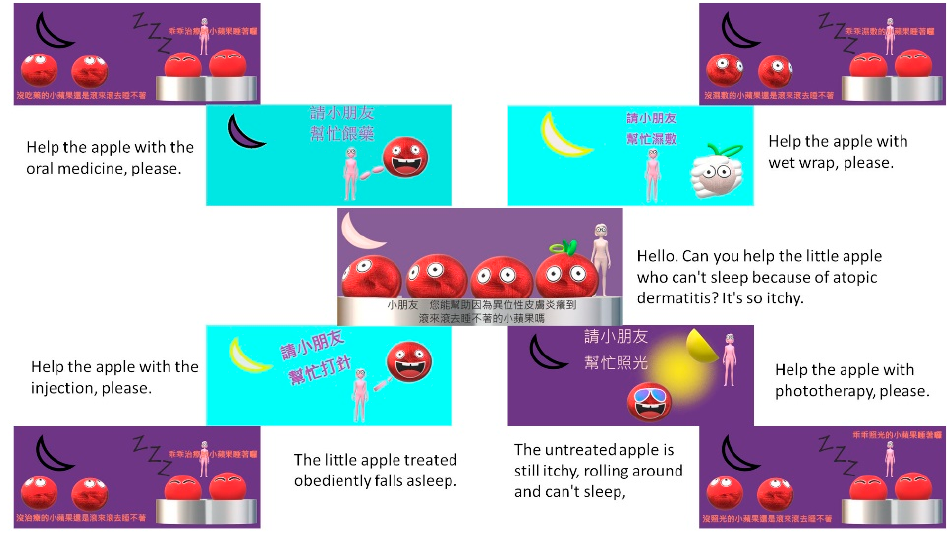
Figure 2. Instruction of shared decision making with animated PowerPoint slide. Table 1. System usability scale of multimedia mixed reality interactive game of shared decision- making in participating